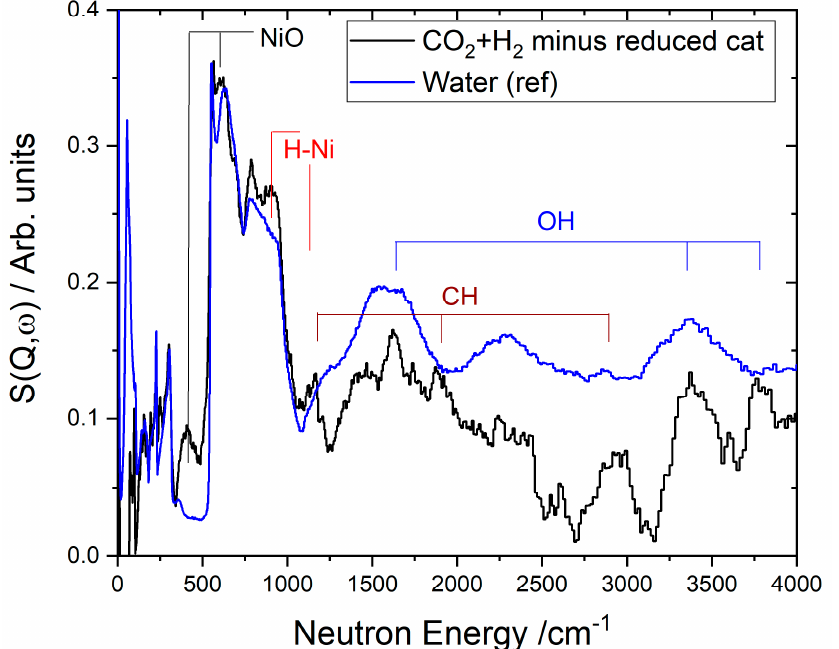
Figure 7. INS difference spectrum of Ni on alumina/silica under methanation conditions (catalyst in CO 2 /hydrogen minus reduced catalyst, black curve, for measurement procedure see Figure 2). The blue curve is a INS reference spectrum of water (ice Ih).